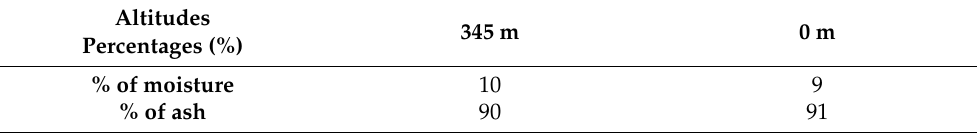
Table 5. Percentages of moisture and ash in E. camaldulensis .